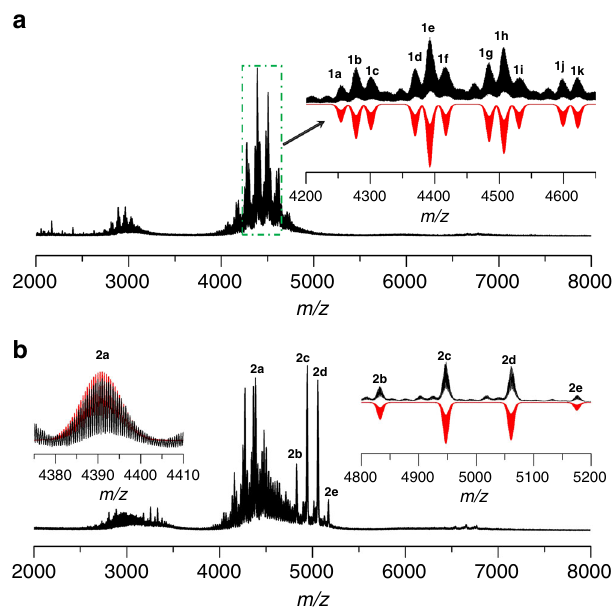
Fig. 4 ESI-MS. a Positive ion mode ESI-MS of the crystals of SD/Ag44 dissolved in dichloromethane. Inset: The zoom-in mass spectrum of experimental (black line) and simulated (red line) isotope patterns for each labeled species. b Positive ion mode ESI-MS of the crystals of SD/Ag50 dissolved in dichloromethane. Insets: The zoom-in mass spectrum of experimental (black lines) and simulated (red lines) isotope patterns for each labeled